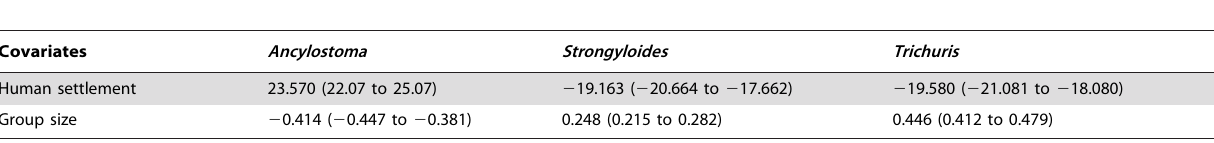
Table 3. Parameter estimates from linear regression models for the influence of human settlements (presence/absence) and group size on prevalence of three groups of gastrointestinal parasites of lion-tailed